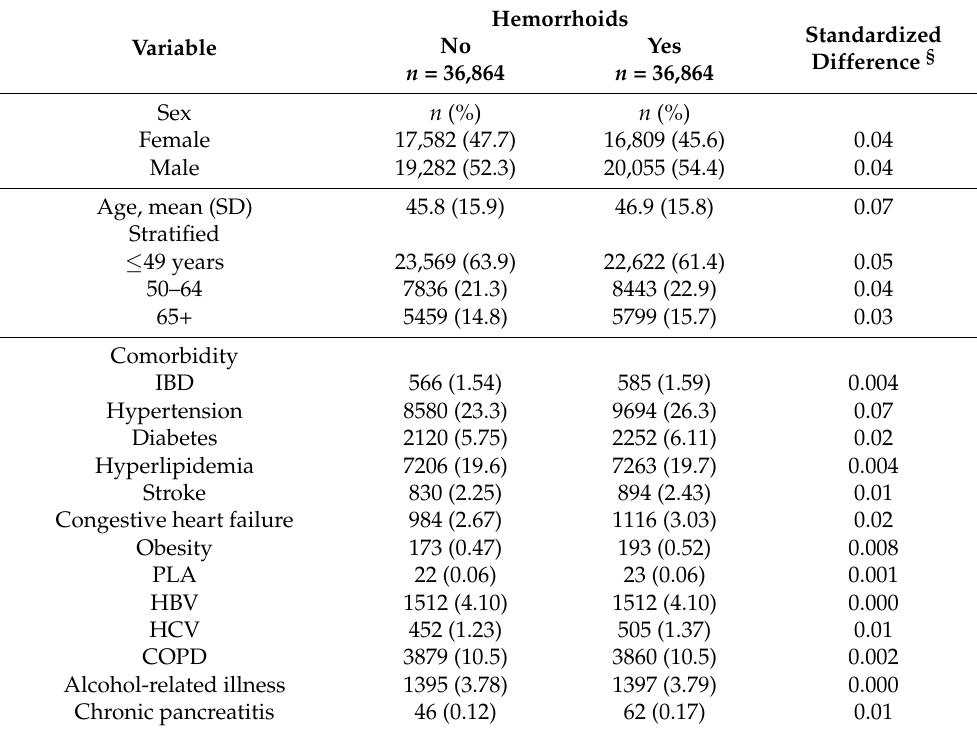
Table 1. Demographic characteristics and comorbidities that were compared between cohorts with and without hemorrhoids who were matched by propensity score without colonoscopies. Hemorrhoids Variable